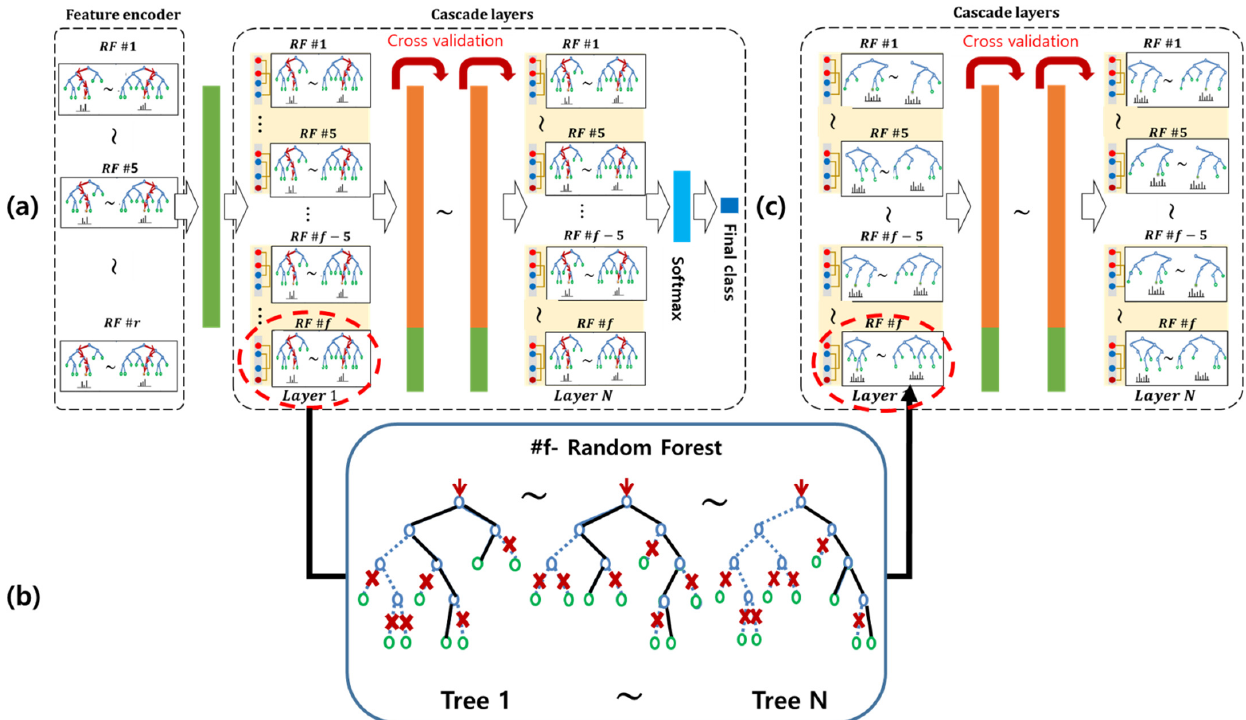
Figure 1. Overall architecture of model simplification using an sLMRF: ( a ) after an LMRF is generated, each RF consists of a large number of decision trees, ( b ) an RF can be simplified by decomposing rules based on the feature contribution, and ( c ) the simplified cascade layers of sLMRF.